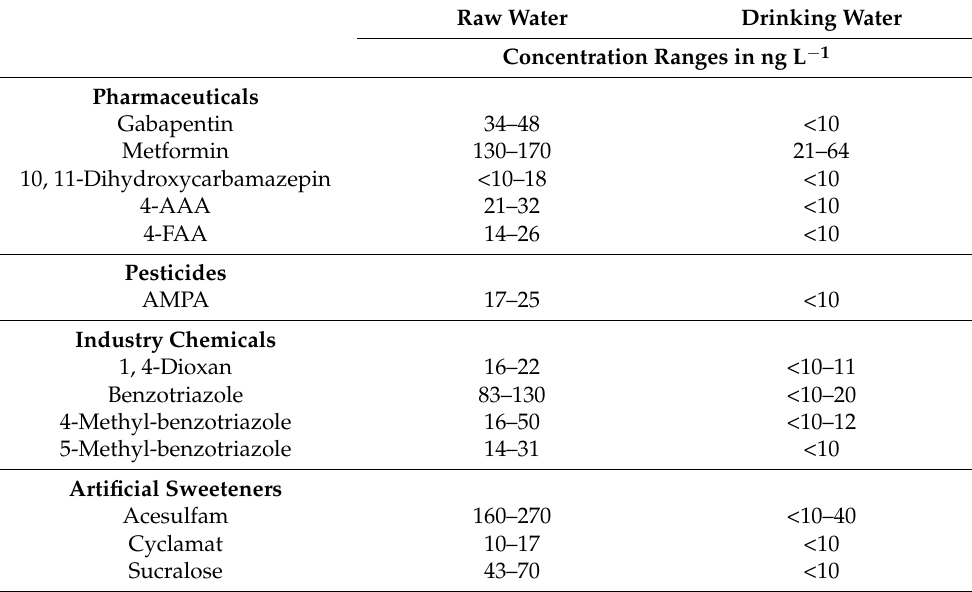
Table 1. Occurrence of selected micropollutants in raw water and drinking water, Lake Constance Water Supply Treatment Plant in